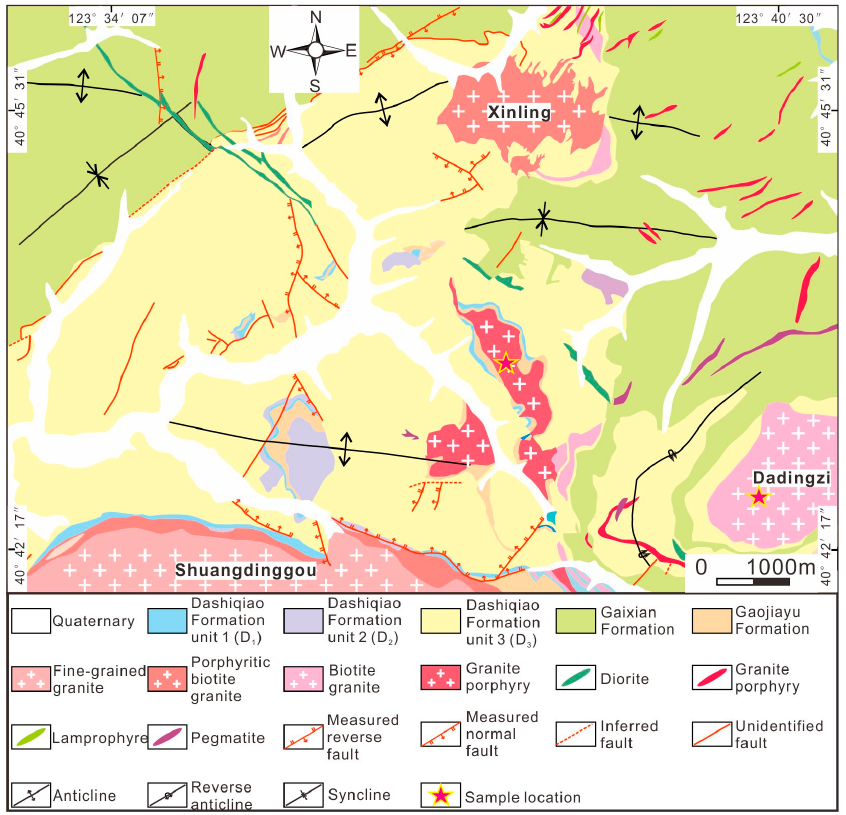
Figure 2. Geological map of the Qingchengzi district (after Li et al. [44]). Minerals 2020 , 10 , x FOR PEER REVIEW